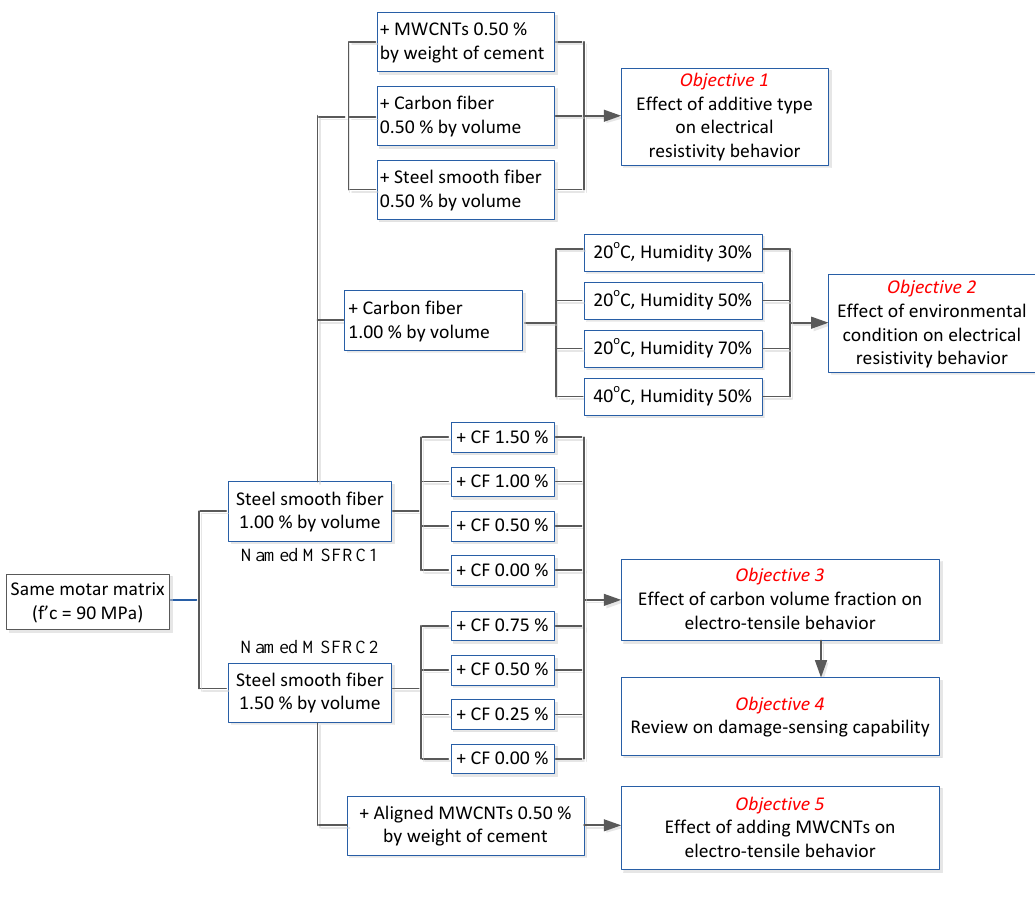
Figure 1. Experimental program on a flowchart.